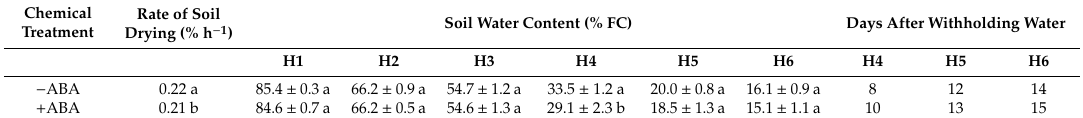
Table 1. The rate of soil drying, soil water content at each harvest, and the number of days after withholding water until the initial decrease in relative water content (H4), temporary wilting (H5) and permanent wilting (H6) in soybean cultivar Jindou 19 (JD) with (+ABA) and without (−ABA) 10 µM exogenous ABA. Values are the mean ± SE ( n = 3). Means within a column with a different letter are statistically different at p = 0.05. H1: One day after the water and chemical treatments; H2: Stomatal conductance significantly decreased without exogenous ABA; H3: Soil water content declined at about 55% field water capacity (FC).